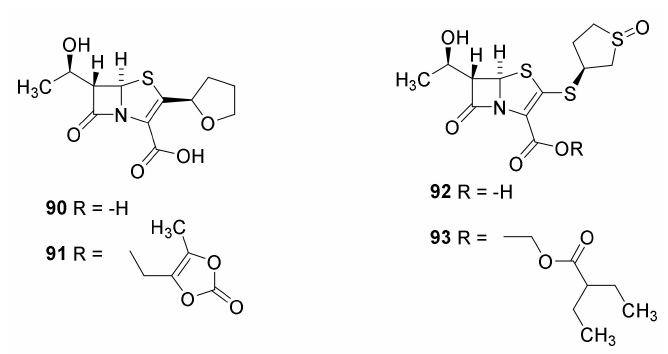
Figure 20. Faropenem ( 90 ), faropenem medoximil ( 91 ), sulopenem ( 92 ) and sulopenem etzadrozil ( 93 ).